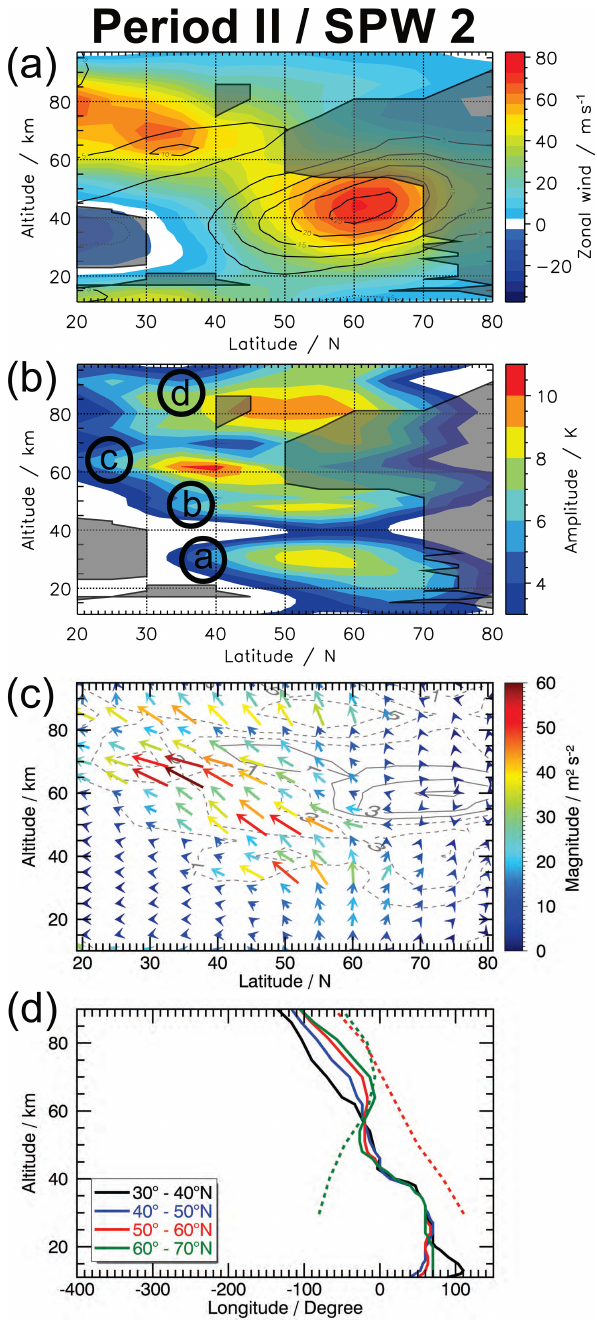
Figure 3. Same as Fig. 2 but for the SPW 2 in Period II. In addi- tion, Fig. 3d shows the phase information of the GW drag filtered for SPW 2 depending on the altitude and for different latitude bands (dashed curves). The GW drag data are derived from SABER ob-